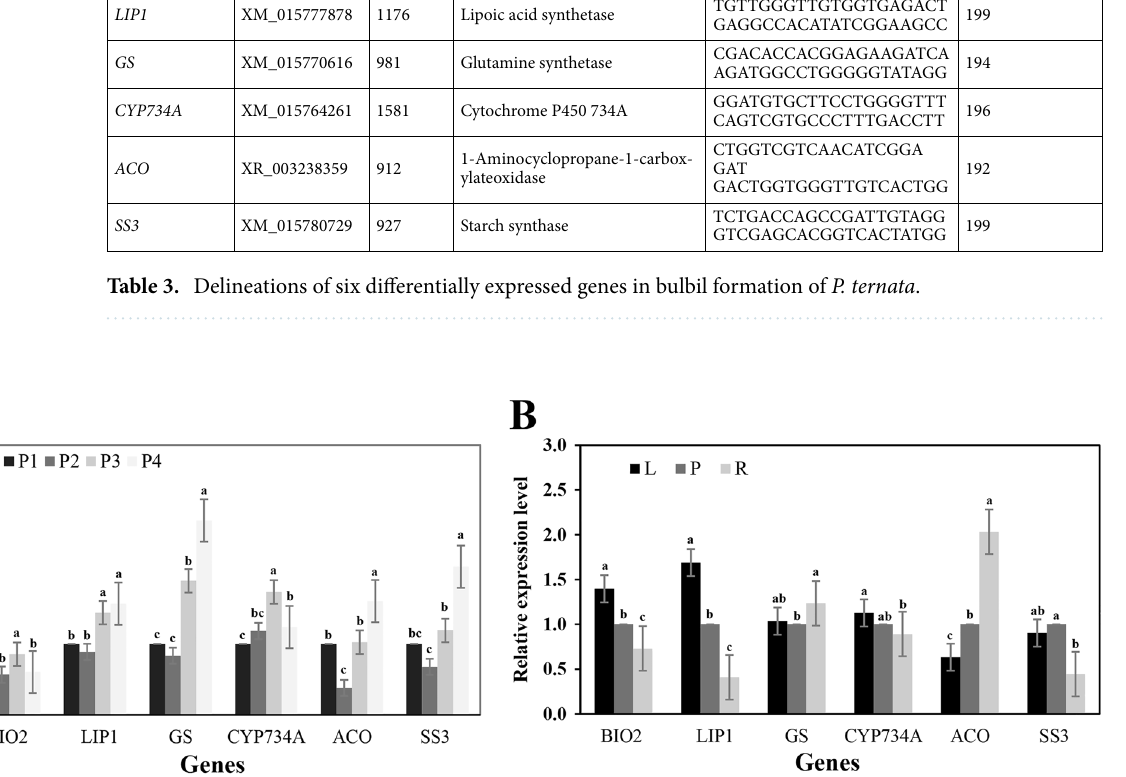
Figure 8. Relative expression levels of selected genes in different tissues and stages of bulblet development of P. ternata . The results were normalized using the selected stable reference gene in sample sets. The bars indicate the standard error (± SE) evaluated from three biological replicates. ( A ) Different periods. P1 = Period 1; P2 = Period 2; P3 = Period 3; P4 = Period 4. ( B ) Different tissues. L = Leaf; P = Petiole; R = Root. a, b, c, differences in expression levels of the same gene in different tissues and at different periods, according to the least significant difference (LSD) test p ≤